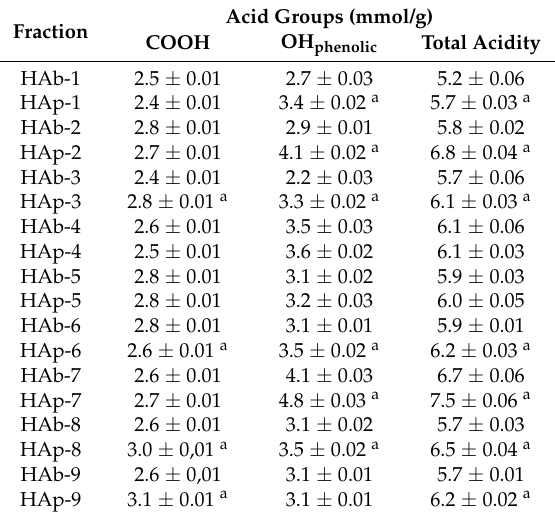
Table 3. Acidic functional groups of the HA fractions determined by chemical